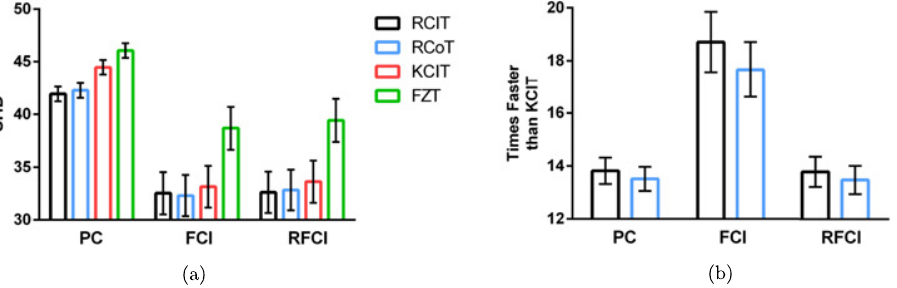
Figure 3: Results of CCD algorithms as evaluated by mean (a) SHD and (b) run times. The CCD algorithms run with KCIT perform comparably (or even slightly worse) to those run with RCIT and RCoT in (a). Run times in (b) show that the CCD algorithms run with RCIT and RCoT complete at least 13 times faster on average than those with KCIT. Error bars denote 95% confidence inter- vals of the